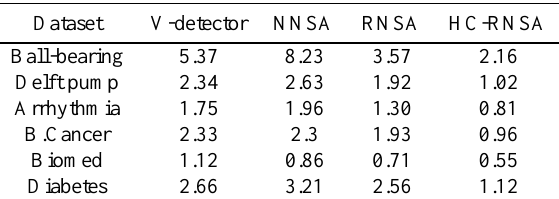
Table 4. The time cost of the detector generation process ( h ).